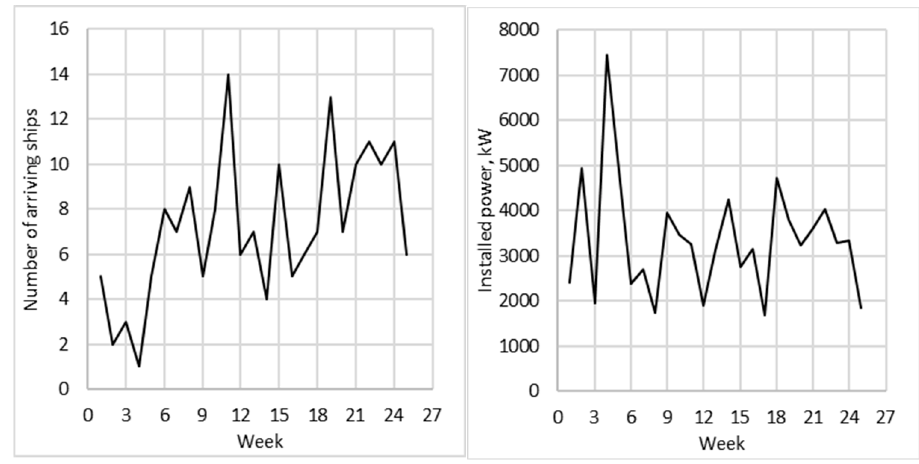
Figure 4. Average arriving ships ( left ) and installed engine power ( right ).